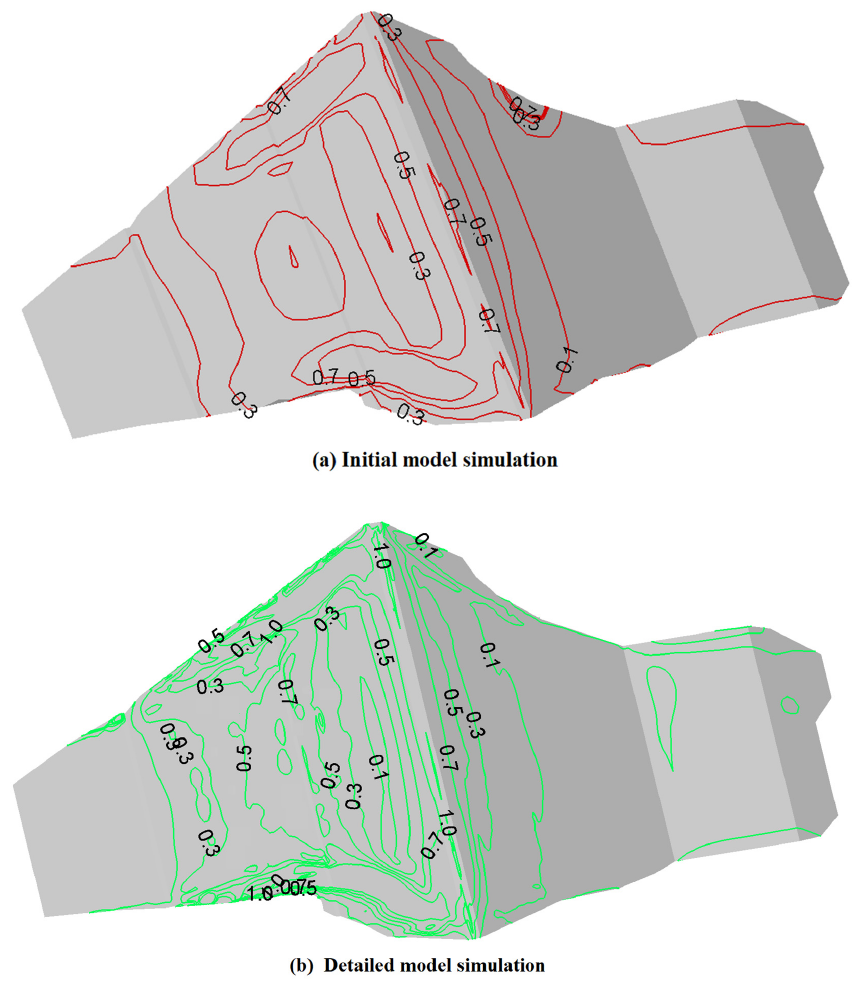
Figure 13. Deformation inclination of the dam surface.